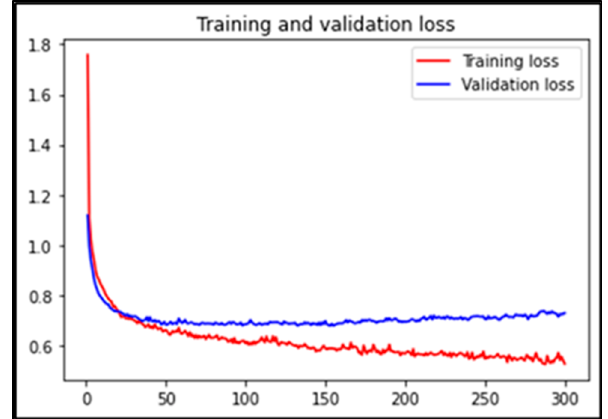
Figure 7. Curves of the loss function.